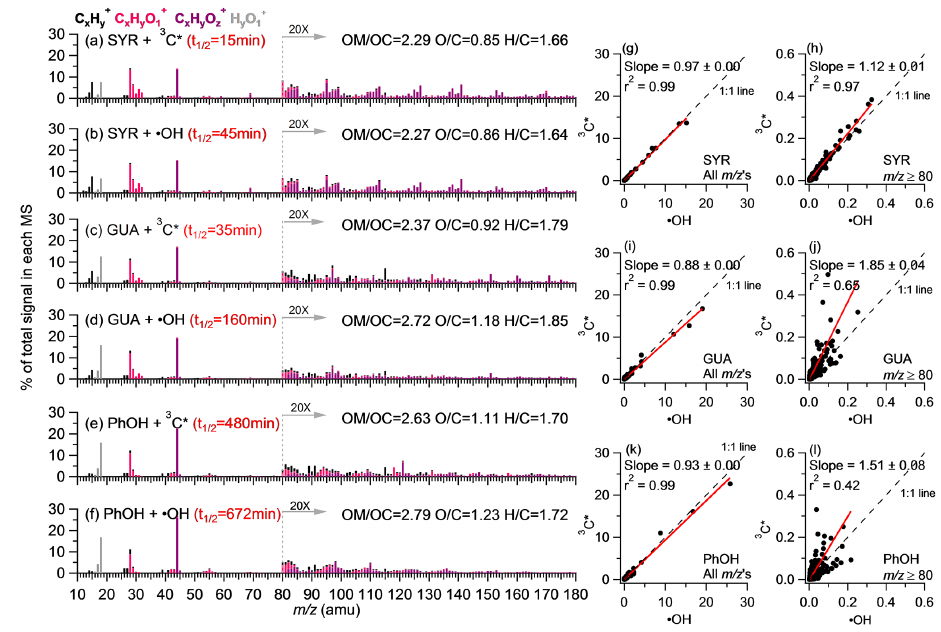
Figure 2. AMS spectra of aqSOA formed from the reactions of (a–b) syringol (SYR), (c–d) guaiacol (GUA), and (e–f) phenol (PhOH) with 3 C ∗ and · OH, respectively. The peaks are color-coded according to four ion categories: C y ≥ 0; z ≥ 2). The ion signals at m/z ≥ 80 are enhanced by a factor of 20 for clarity. The photoreaction time and the elemental ratios of the aqSOA are shown in the legends. Scatter plots that compare the mass spectra of aqSOA formed from two different oxidants for all m/z ’s (g, i, k) and for m/z ≥ 80 (h, j, l) were performed using the orthogonal distance regression (ODR). The linear regression slopes and correlation coefficients are shown in the legends.